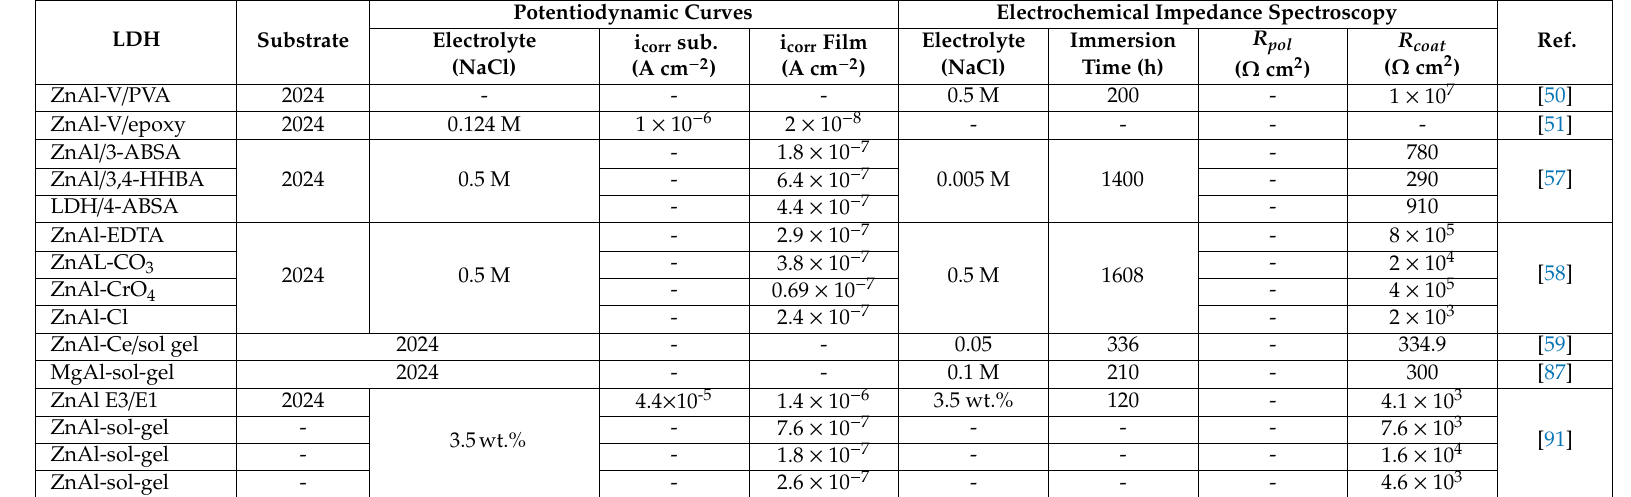
Table 3. LDH particles dispersed in organic / polymeric matrix, and corresponding measured corrosion resistance